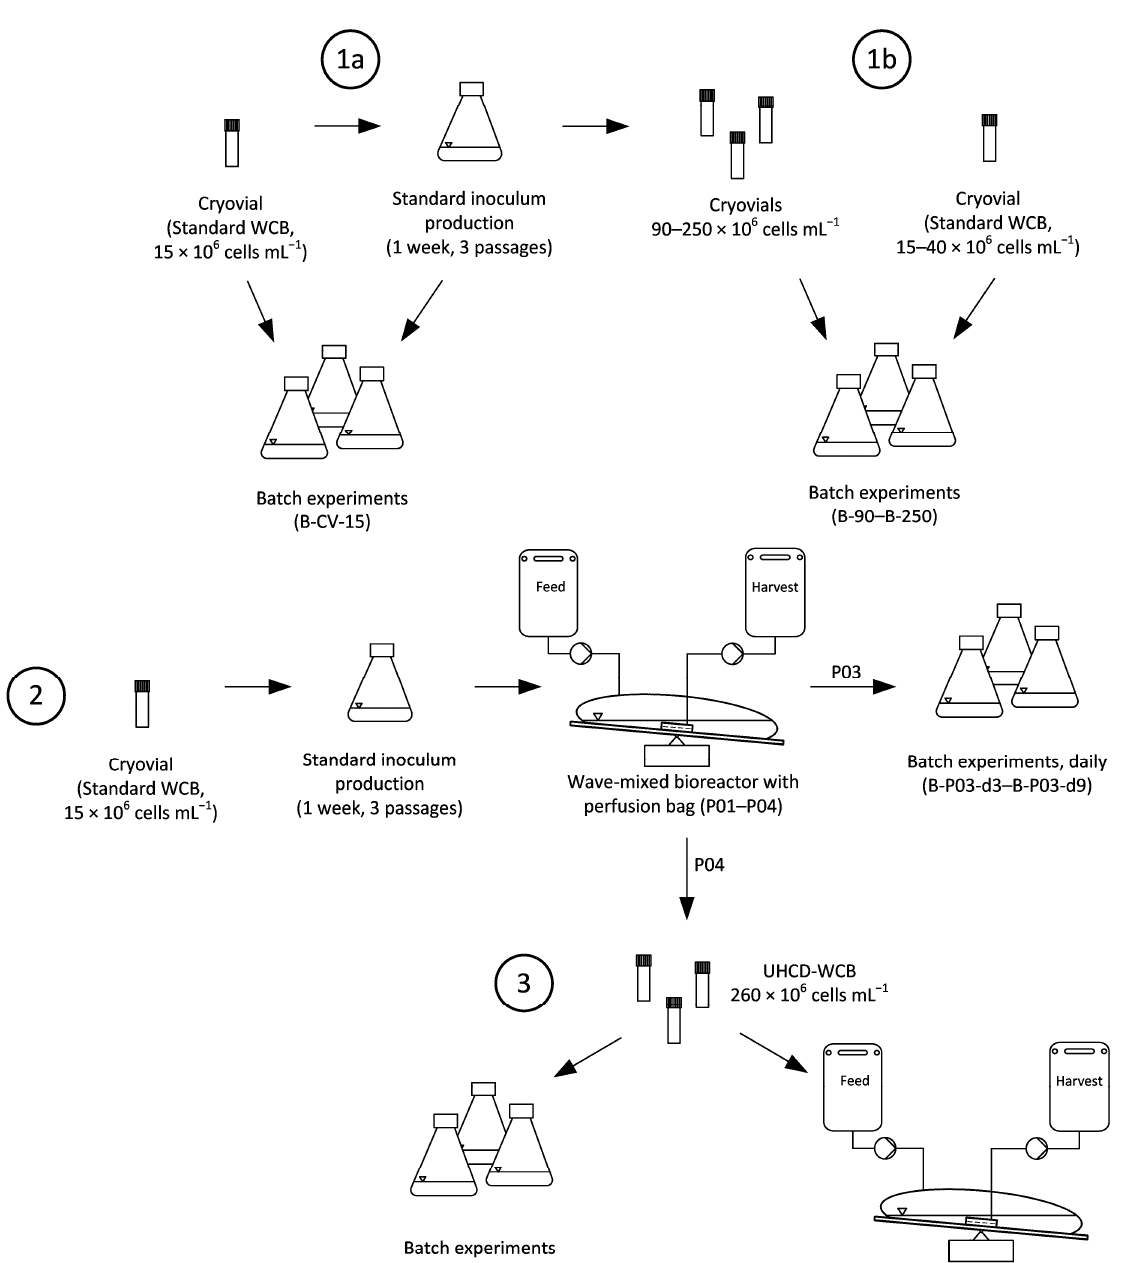
Figure 1. Schematic representation of the experiment design: ( 1a ) Direct inoculation out of cryovials (B-CV-15) vs. standard inoculum production, freezing of different VCDs; ( 1b ) Direct inoculation from standard cryovials vs. cryovials with higher cell densities (B-90–B250; 90–250 × 10 6 cells mL − 1 ); ( 2 ) Perfusion processes (P01–P04) with standard inoculum production, daily inoculation of batch experiments (B-P03-d3–B-P03-d9), and freezing of the UHCD-WCB; ( 3 ) Performance test of the UHCD-WCB in batch (B-UHCD) and perfusion (P05) experiments.